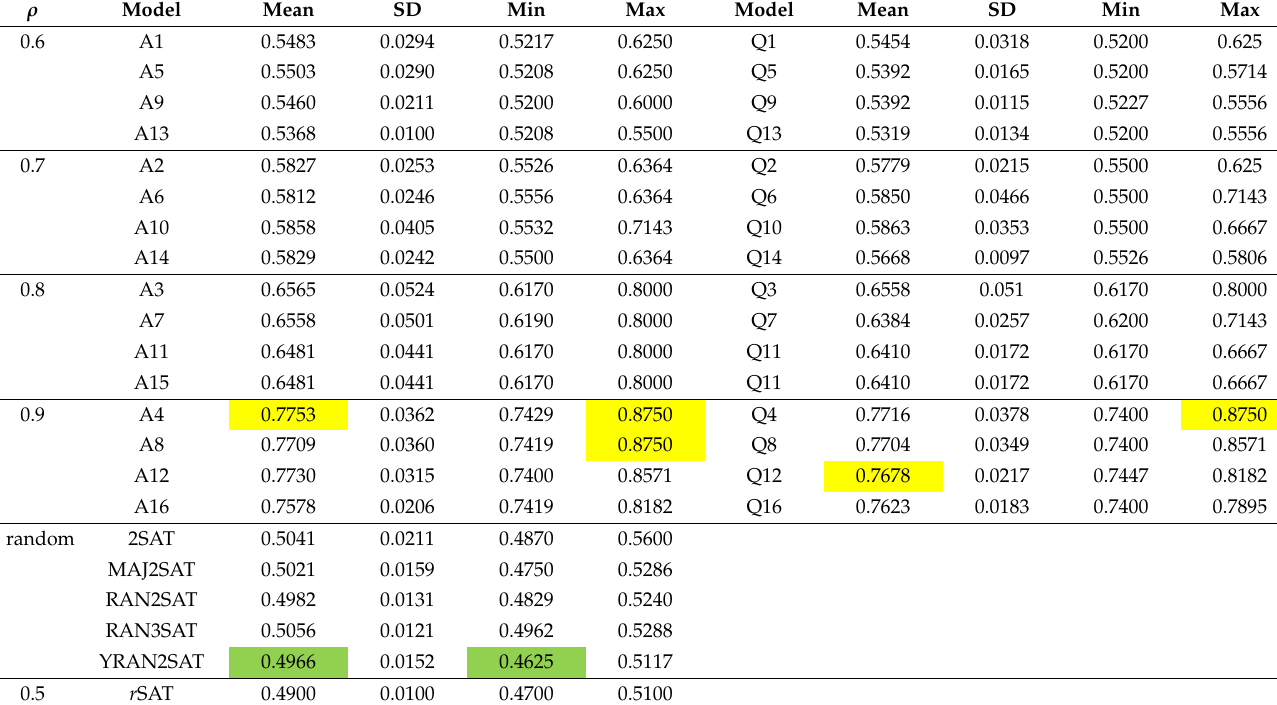
Table 8. PNO results for models with both types of logic, δ 1 2 SAT ρ and δ 2 2 SAT ρ , and recently developed logic systems’ details determined by Wilcoxon test for median divided by ρ value.